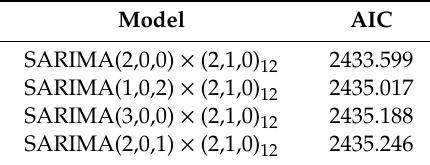
Table 1. Akaike Information Criterion (AIC) from some of the forecast models tested at the Momil station. Table1. AkaikeInformationCriterion(AIC)fromsomeoftheforecastmodelstestedattheMomilstation.